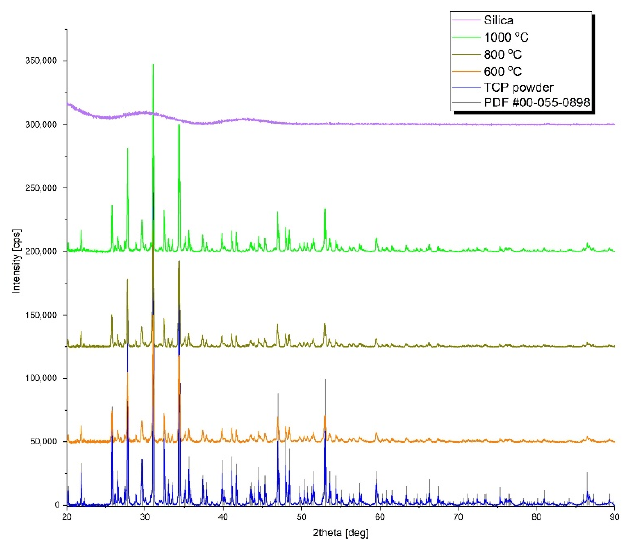
Figure 7. X-ray diffraction patterns of silica aerogel and β -TCP-modified aerogels before and after heat treatments. The positions of diffraction peaks from the PDF database (#00-055-0898) are also shown.